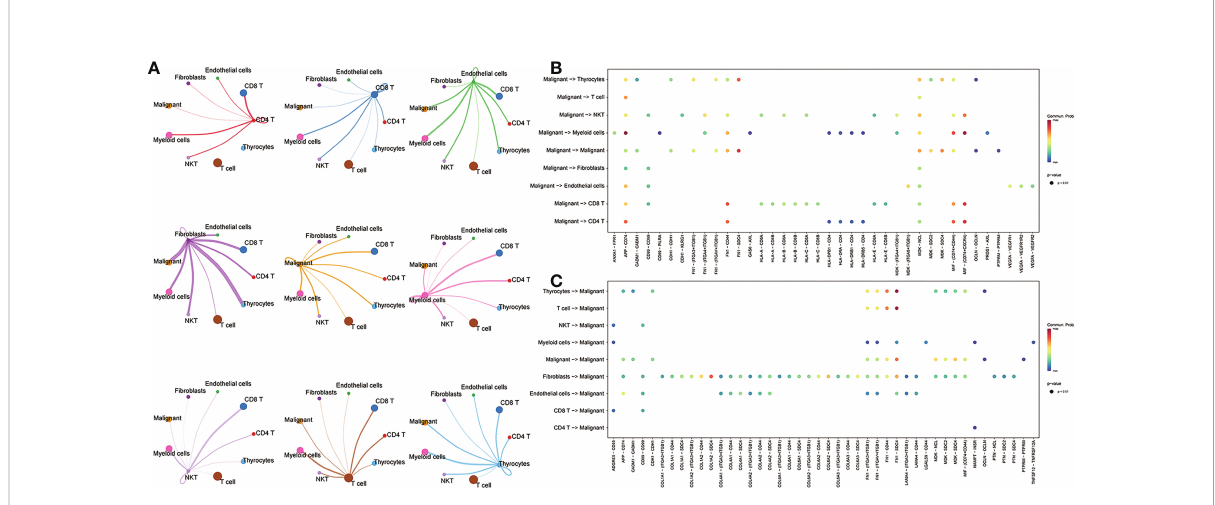
FIGURE 2 The L/R pairs between malignant cells and normal cells. (A) The ligand-receptor interactions among cells. Thicker lines represent more interactions (more ligand receptors). (B) Bubble plot of L/R pairs communicating between ligands of malignant cells and receptors of non- malignant cells; (C) Bubble plot of L/R pairs communicating between ligands of non-malignant cells and receptors of malignant cells; the color represents the magnitude of the force, and the larger the point, the smaller the p-value